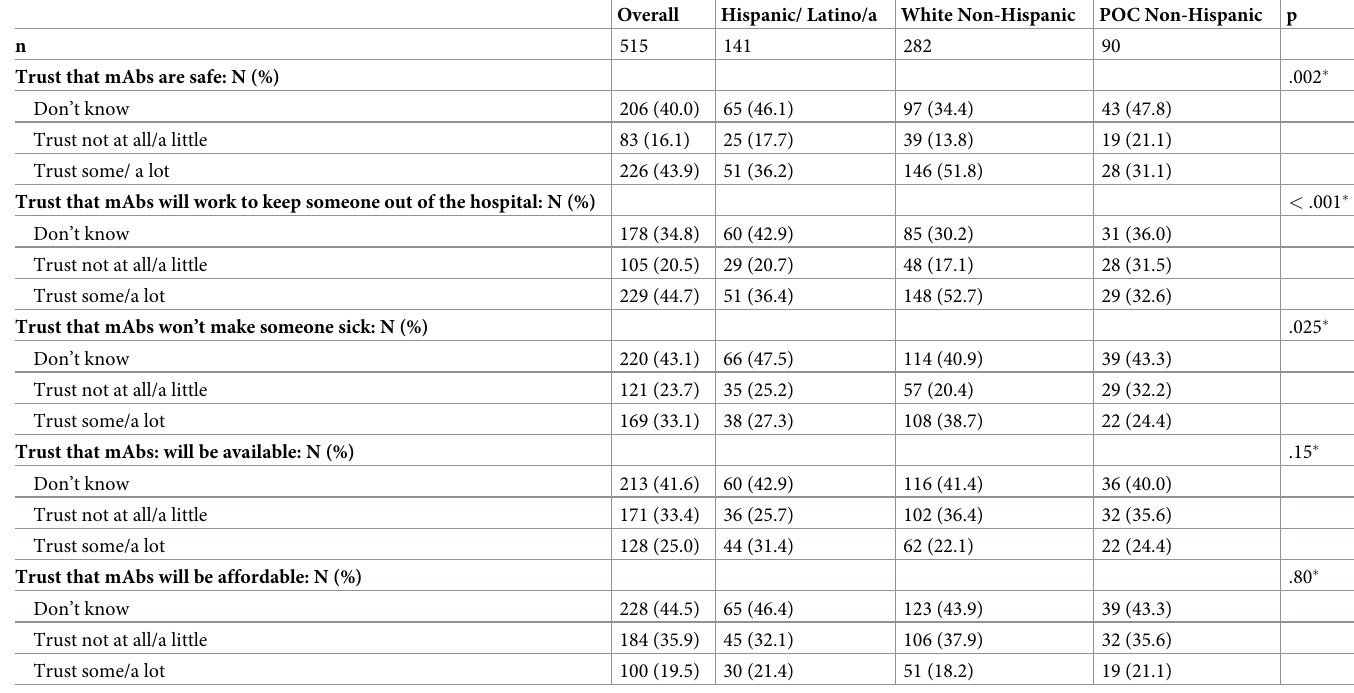
Table 3. Trust in monoclonal antibody treatment for COVID-19 by